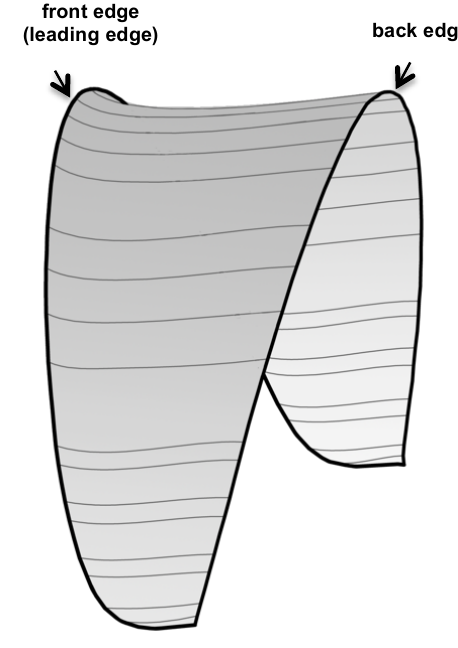
Fig. 10: Final 3D model of the paraglider’s lower